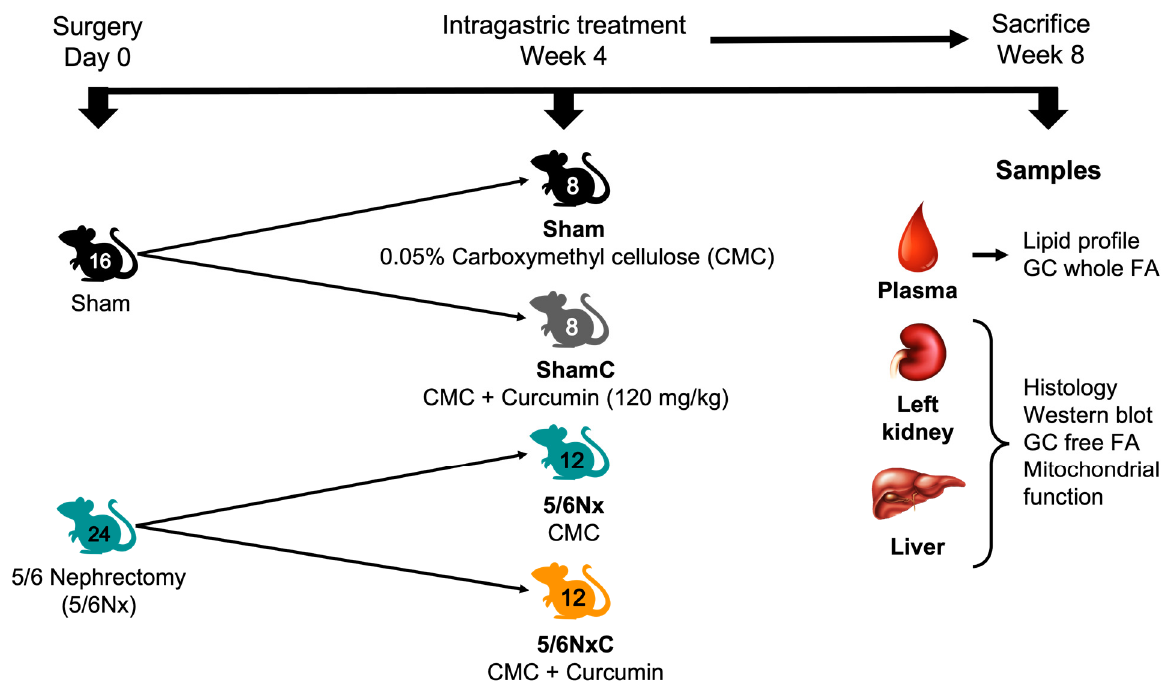
Figure 1. Experimental design. GC = Gas Chromatography and FA = Fatty Acids.